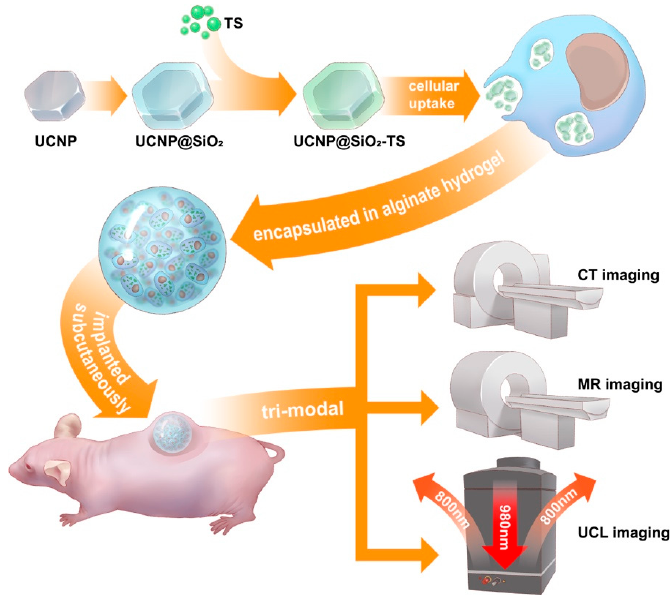
Figure 1. A schematic diagram of the